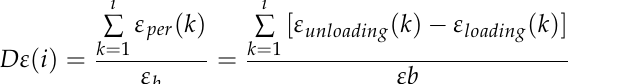
Figure 9. Curves of the damage variable D ε and cycle number.